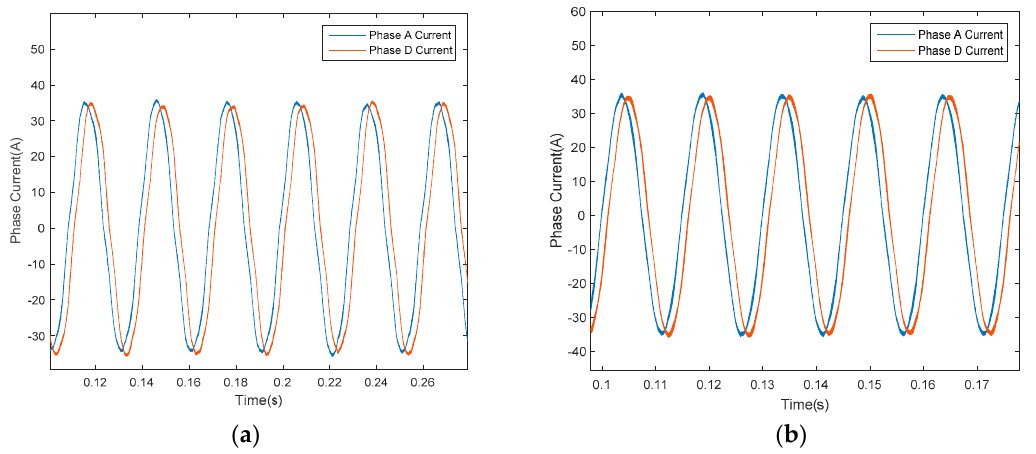
Figure 15. Phase A and D currents after adopting the proposed feedforward voltage compensation method only, ( a ) speed is maintained at 500 rpm, and ( b ) speed is maintained at 1000 rpm.